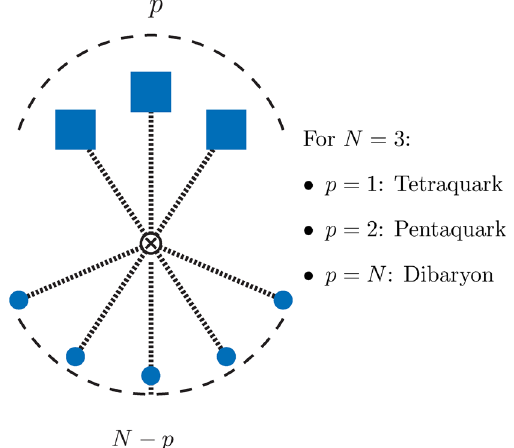
Fig. 1 Multiquark hadrons generated by the substitution (1) in N colours QCD. Full boxes indicate the generalised diquarks in (4) and full dots the antiquarks; dotted lines are QCD strings, the crossed circle at the center represents the N dimensional (cid:2) symbol that joins the N representations ¯ N into an SU ( N ) singlet. Hadrons resulting for N = 3 are indicated. For brevity, the same names are used in the text for the configurations with the same value of p in N colours QCD (cid:7) D =